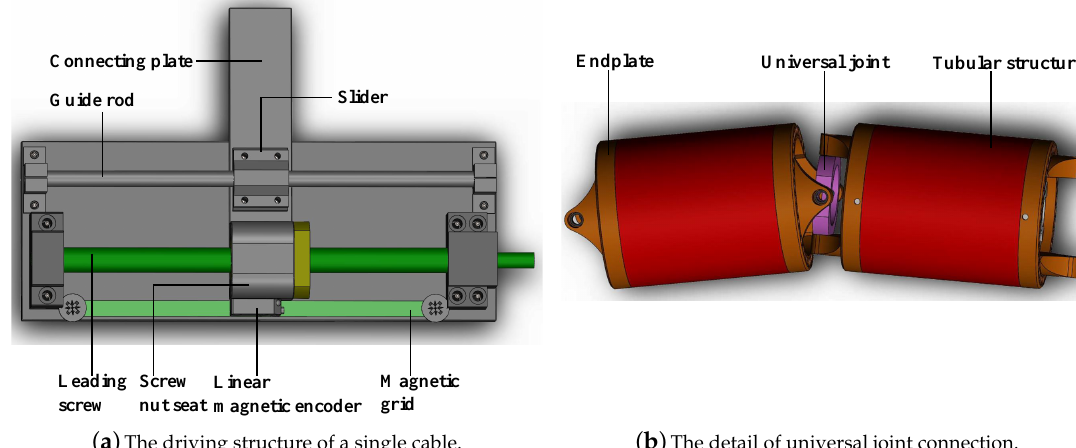
Figure 2. The details of driving or motion subsystems.